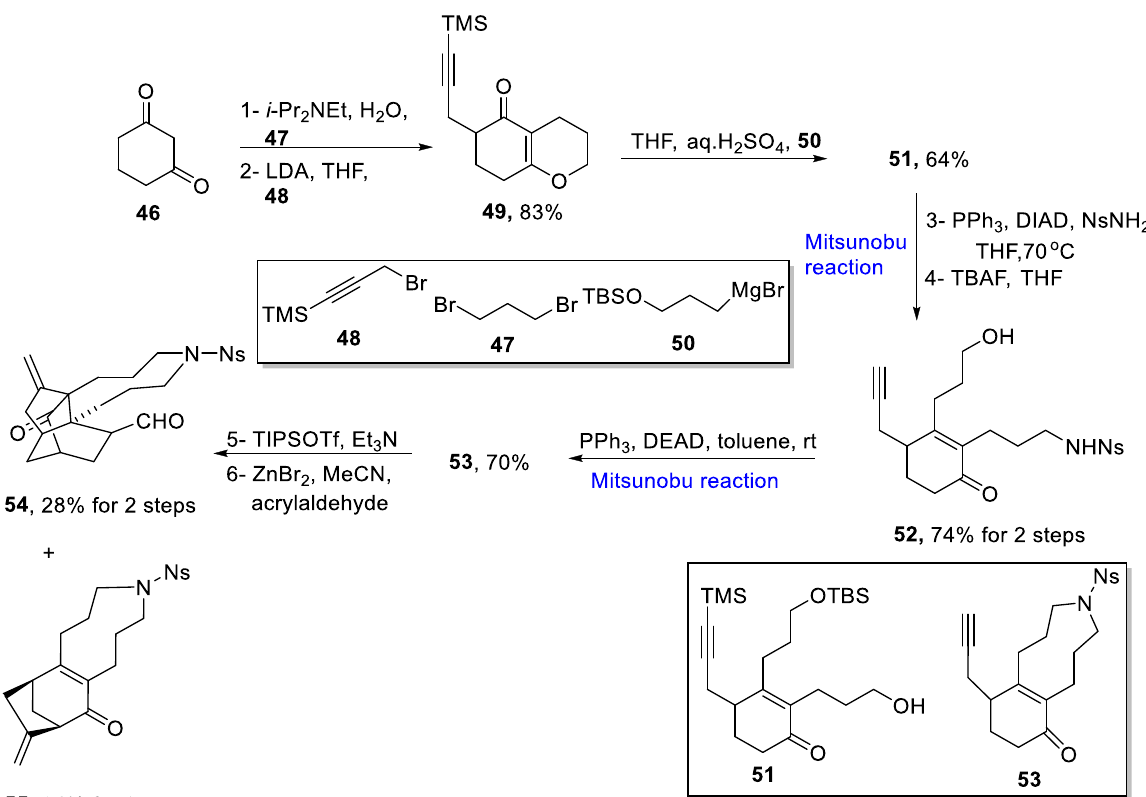
Scheme 8. Total synthesis of a palhinine alkaloid